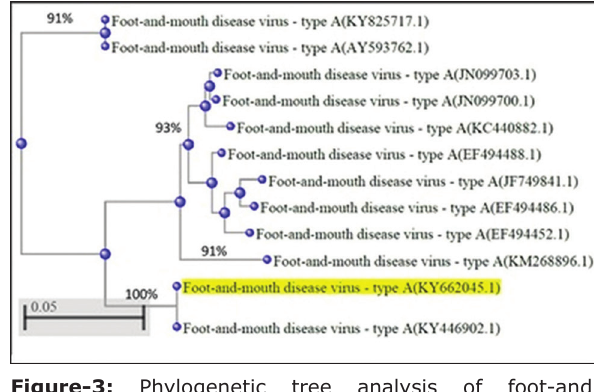
Figure-3: Phylogenetic tree analysis of foot-and- mouth disease virus type A with several closed strains characterized previously in neighbor countries.